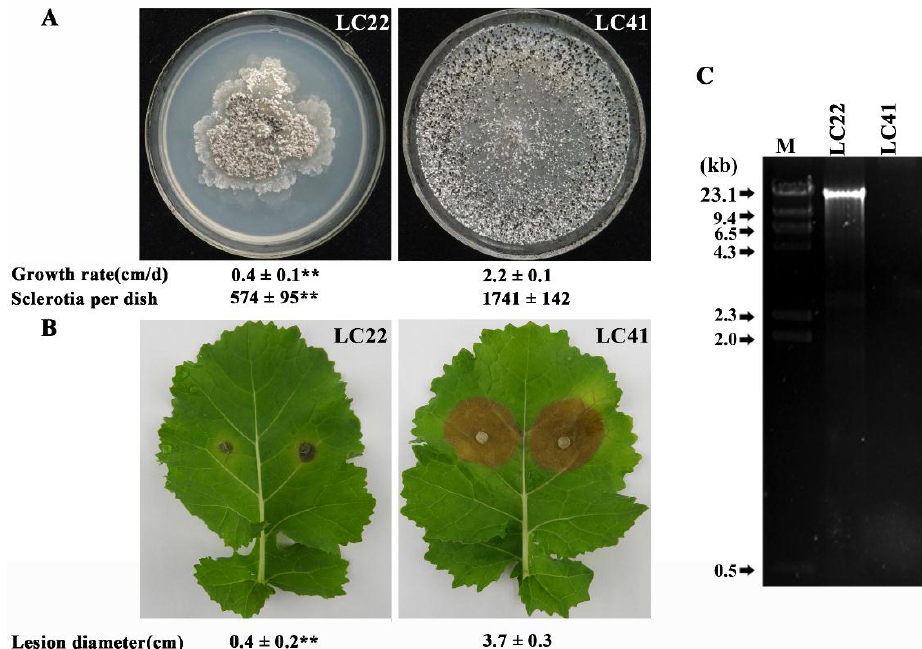
Figure 1. Comparison of strains LC22 and LC41 of Sclerotinia minor in mycelial growth rate, sclerotial production, pathogenicity and presence/absence of dsRNA. ( A ) Colony morphology, growth rate and sclerotial formation on potato dextrose agar (20 °C, 10 d). ** p < 0.01 between LC22 and LC41, Student’s t test; ( B ) Lesions on oilseed rape leaves two days after inoculation (20 °C). ** p < 0.01 between LC22 and LC41, Student’s t test; ( C ) An agarose gel electrophoregram showing the band of the dsRNA extracted from the mycelia of LC22 and LC41. The extracts were treated with S1 nuclease and DNase I before being loaded in the gel for electrophoresis. The DNA marker is λ DNA/ Hind III.